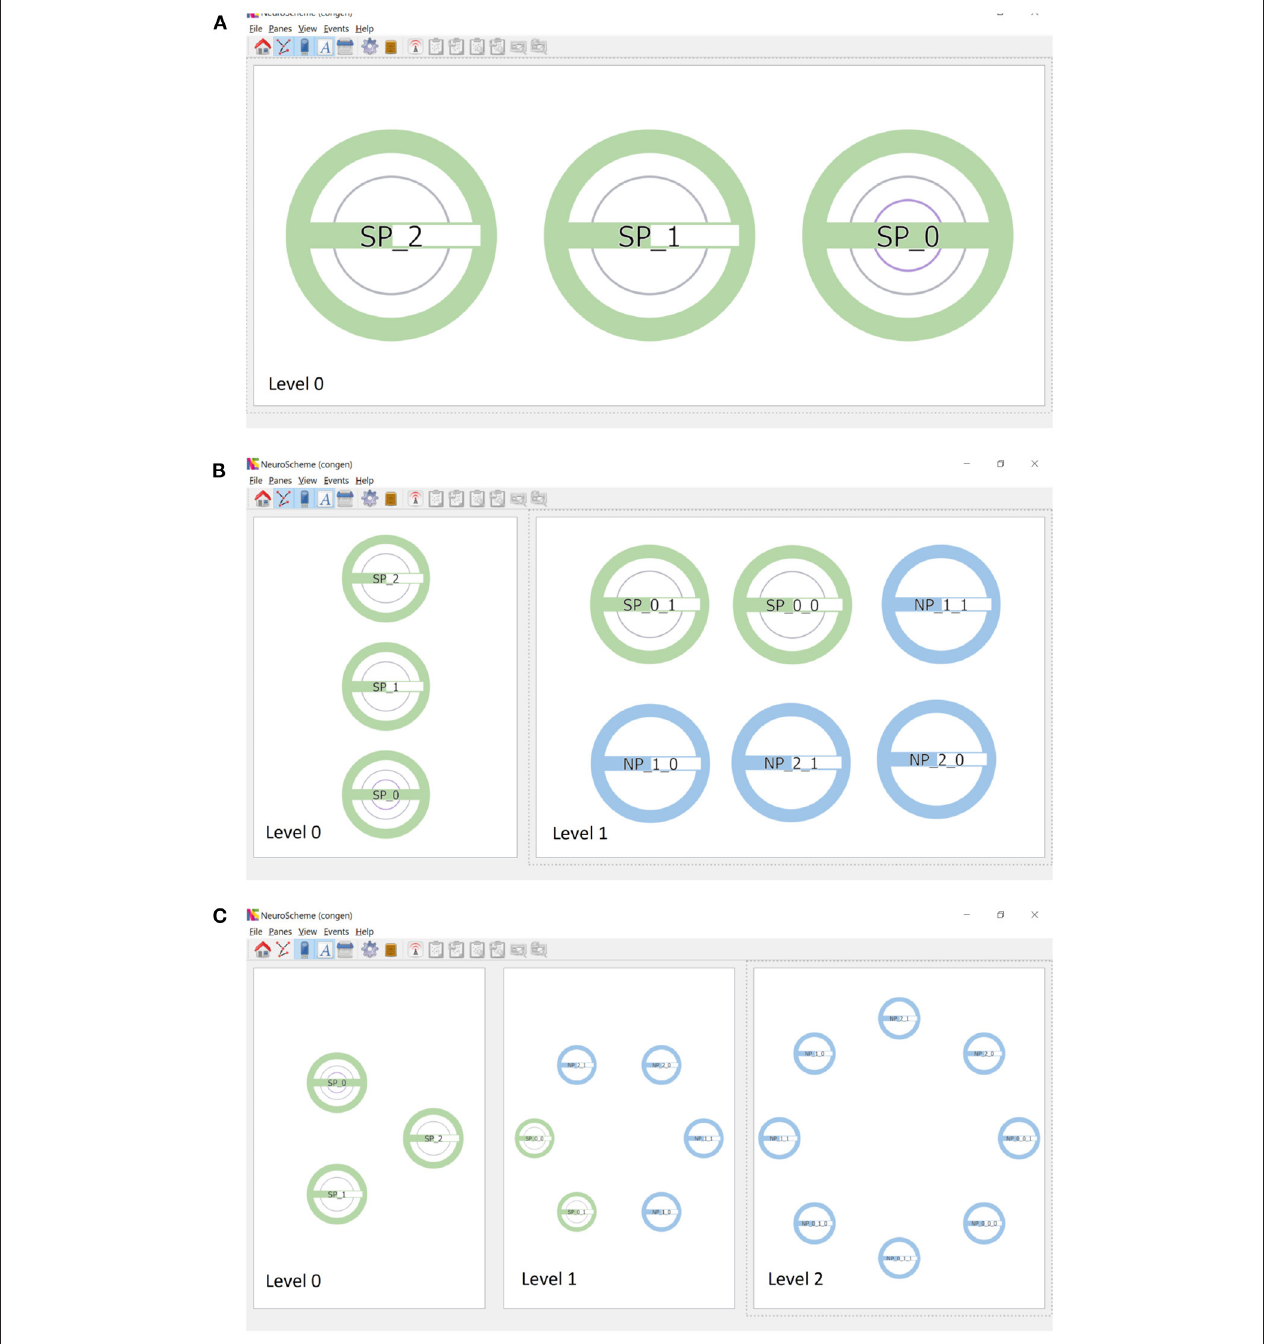
FIGURE 3 | Creation of scenes in ConGen. (A) A scene where SP_0 has two hierarchical descendant levels (indicated by the two inner rings) while SP_1 and SP_2 have one hierarchical descendant level each. The green filling of the horizontal bars indicates that SP_1 and SP_2 have the same number of neurons while SP_0 has twice the amount. (B) Super-populations can be expanded to visualize the next hierarchical level. Left panel: the three super-populations in a collapsed view. Right panel: The three super-populations have been expanded to show their direct children. (C) The panels show the three hierarchical levels of the scene simultaneously. Left: Neuron super-populations at the highest level of abstraction. Middle: The hierarchical entities tree displayed at depth level 2. Right: All entities have been drilled down to show the lowest level of abstraction. Icons have been arranged in a circular layout for convenience for connectivity creation.